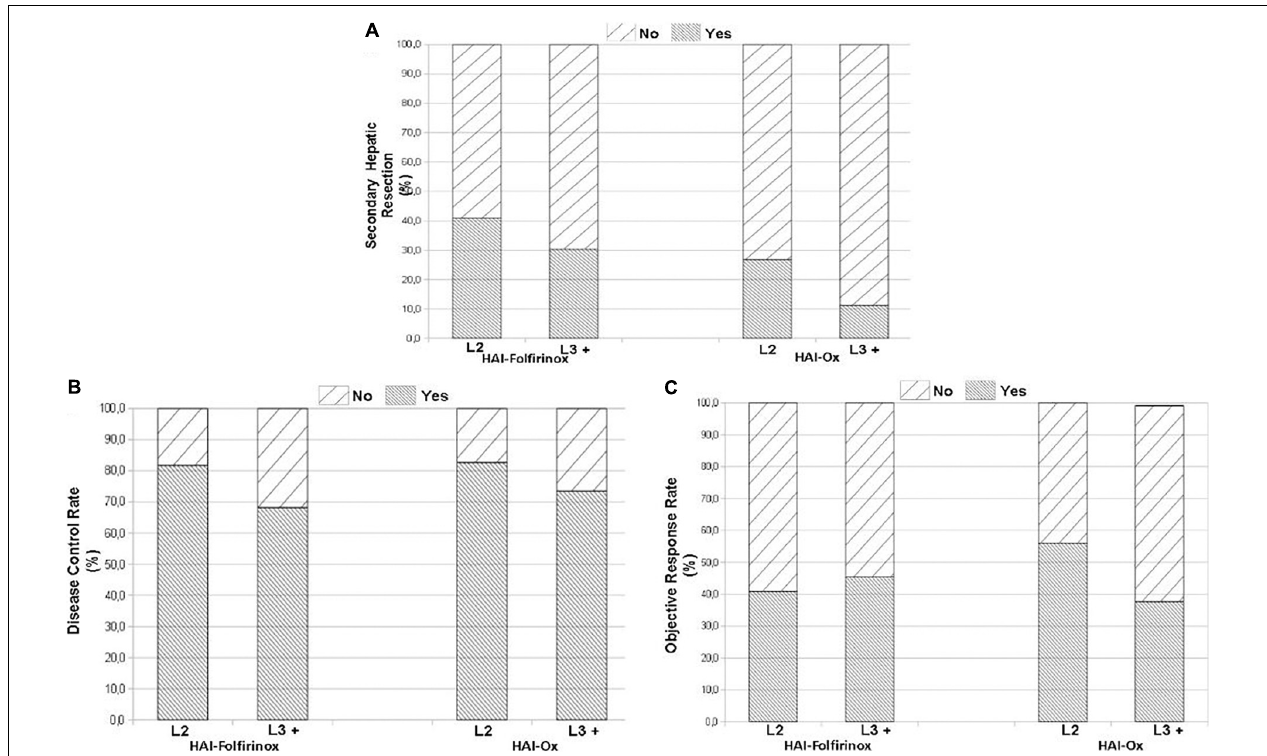
FIGURE 2 | Treatment efficacy when administered second line (L2) or in further lines of treatment (L3 +). Secondary hepatic resection of metastases after hepatic arterial infusion (HAI) treatment (A) . Disease control rate (B) . Objective response rate (C)